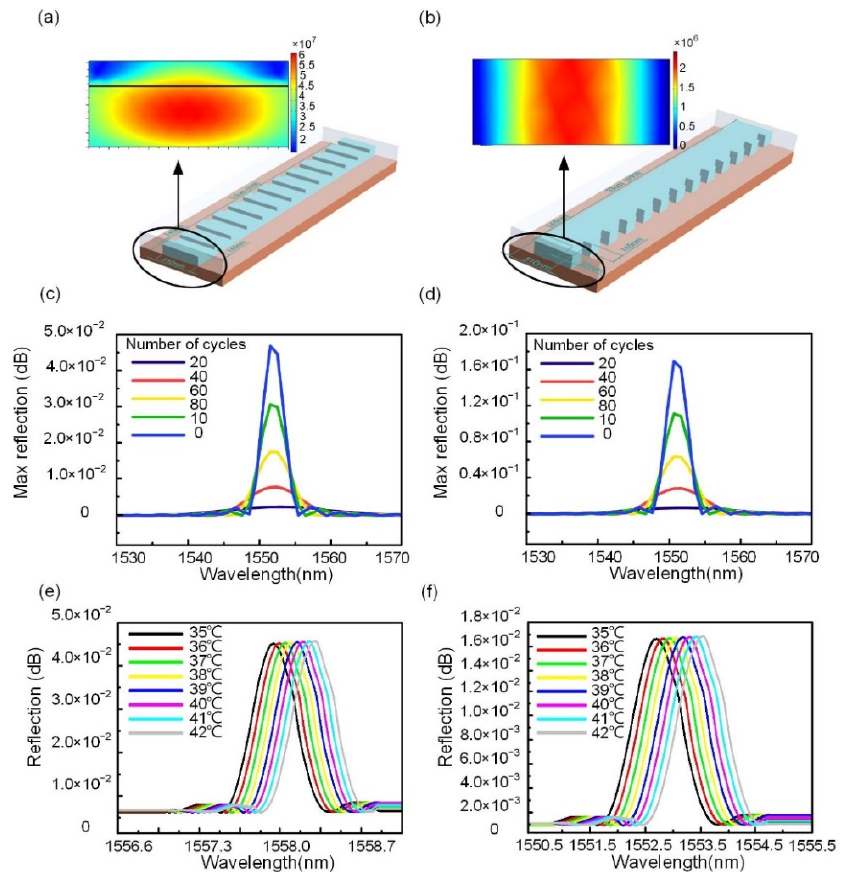
Figure 3. Characterization of top-surface and one-sided WBGs: ( a ) Schematic of top-surface WBG; ( b ) Schematic of one-sided WBG; ( c ) Maximum reflectivity of reflection spectrum of top-surface Bragg grating increases with number of periods; ( d ) Maximum reflectivity of reflection spectrum of one-sided Bragg grating increases with number of periods; ( e ) Reflection spectra of top-surface WBG at different temperatures; ( f ) Reflection spectra of one-sided WBG at different temperatures.